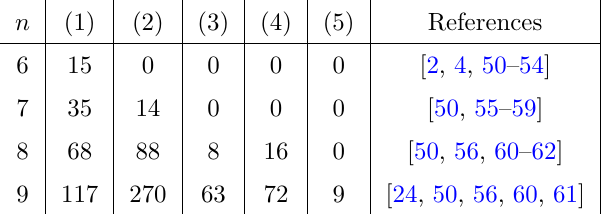
Table 5. Enumeration of rational symbol letters of n -particle amplitudes in SYM, based on the results of all explicit computations available to date, and categorized according to the five types defined in the text. The lines n = 6 , 7 are believed to be complete (see [19]), comprising the 15 and 49 cluster variables of G(4 , 6) and G(4 , 7) , respectively. For n > 7 the counts may grow